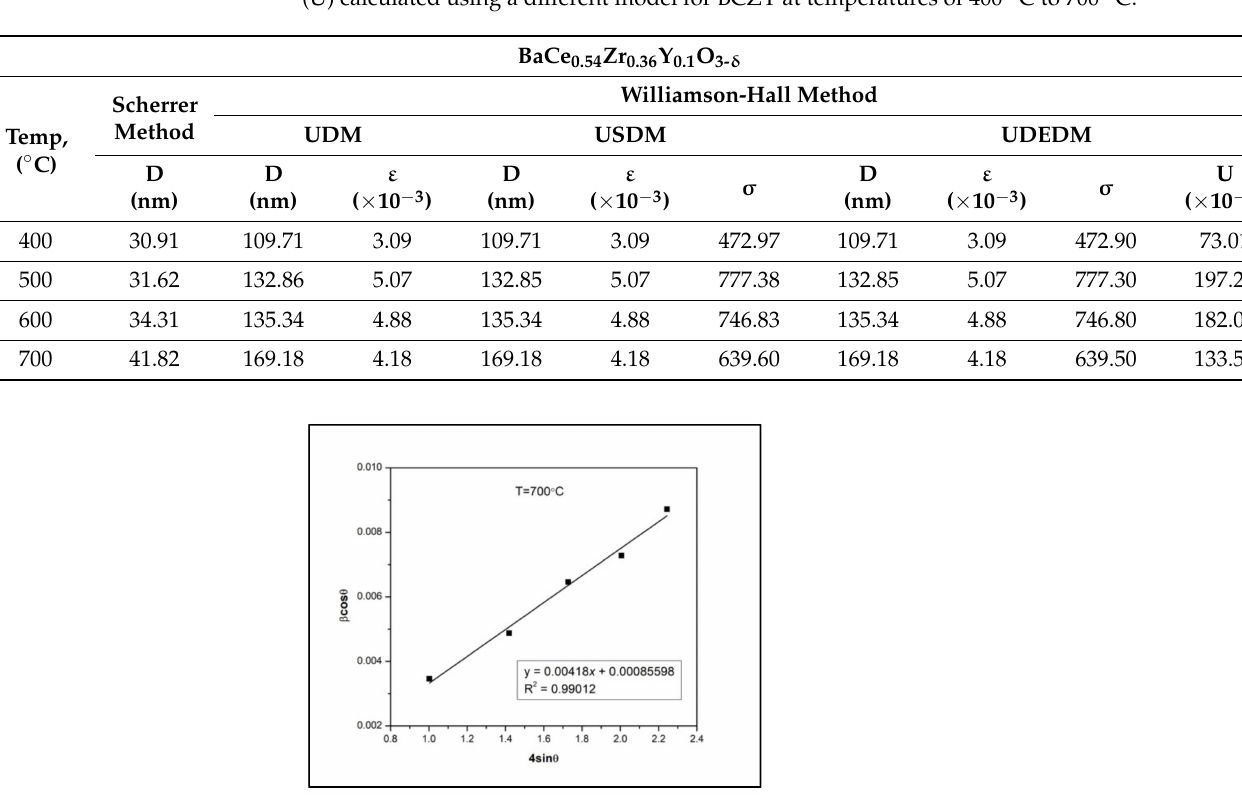
Table 3. Summary of crystallite size (D), lattice strain ( ε ), deformation stress ( σ ) and energy density (U) calculated using a different model for BCZY at temperatures of 400 ◦ C to 700 ◦ C.